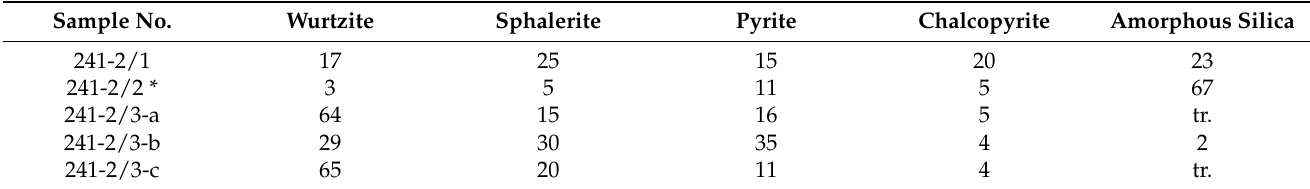
Table 1. XRD-based mineral composition of fragments of Zn-rich chimneys (wt%). Sample No.